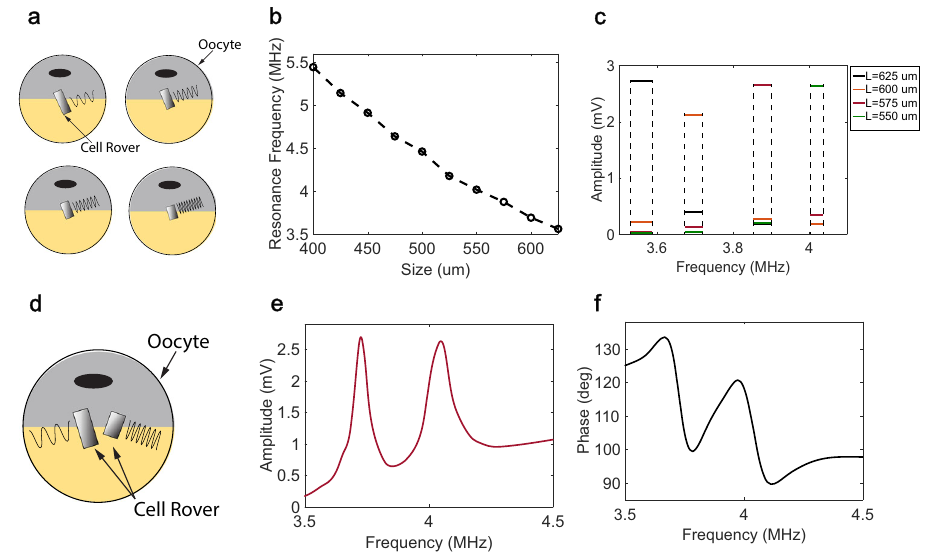
Fig. 5 | Multiplexing using Cell Rovers. a Schematic diagram showing different Xenopus oocytes injected with Cell Rovers of different sizes. Depending on the antenna sizethe resonance frequency of the signal detected from each oocyte will be unique. b Resonance frequency detected from different oocytes injected with different sized Cell Rovers as a function of their size. c Average detected voltage fromcellroversofdifferentsizesfordifferentfrequencyranges.Eachrangeshown